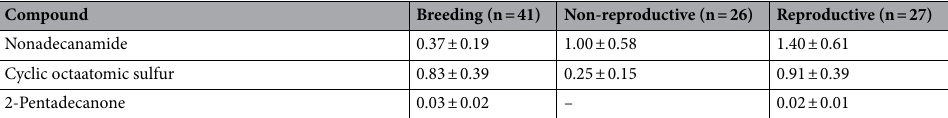
Table 3. Relative proportions (mean ± SE) of compounds in feces of Iberian wolves ( Canis lupus signatus ) depending on the reproductive status of the individuals.